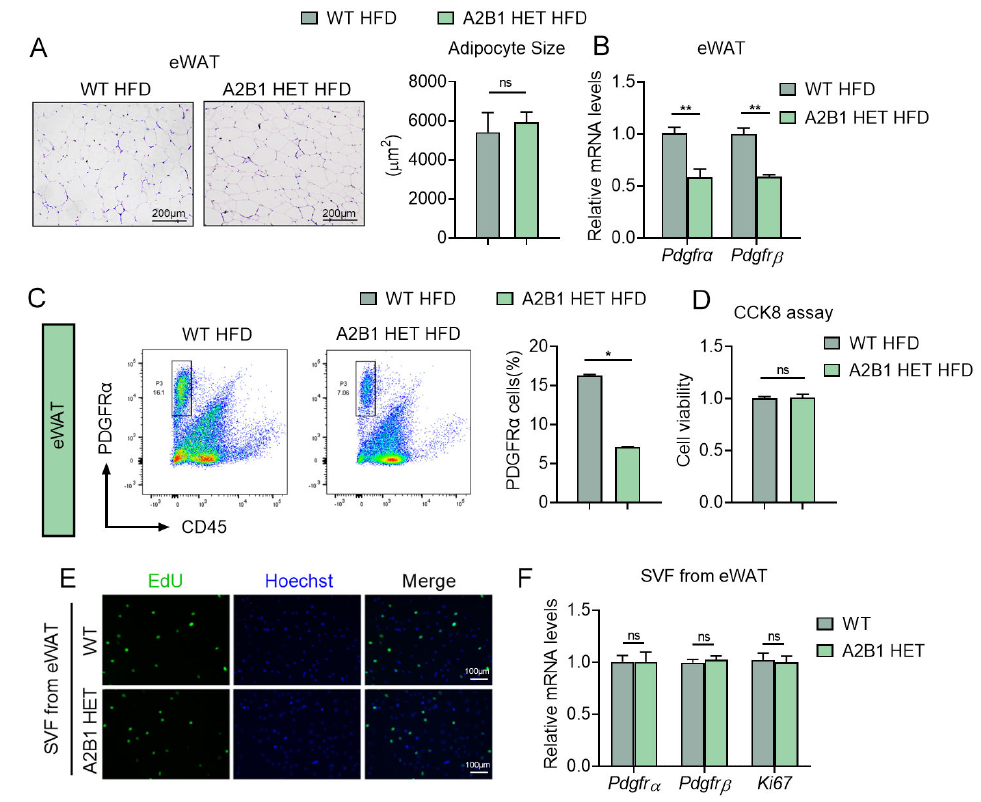
Figure 6. PDGFR α + progenitor cell numbers are reduced in hnRNPA2B1 heterozygous mice. ( A , B ) H&E staining ( A ), Pdgfr α and Pdgfr β mRNA levels ( B ) in epididymal white adipose tissues of HFD-fed WT and A2B1 HET mice. ( C ) Cell sorting of CD45-PDGFR α + cells from eWAT SVF of HFD-fed WT and A2B1 HET mice by FACS. ( D – F ) Proliferation of SVF cells from eWAT of WT and A2B1 HET mice was evaluated by CCK-8 analysis ( D ), EdU analysis ( E ) and relative Pdgfr α , Pdgfr β and Ki67 mRNA expression levels ( F ). Results are shown as mean ± SEM; ns, not significant; * p < 0.05, ** p < 0.01.